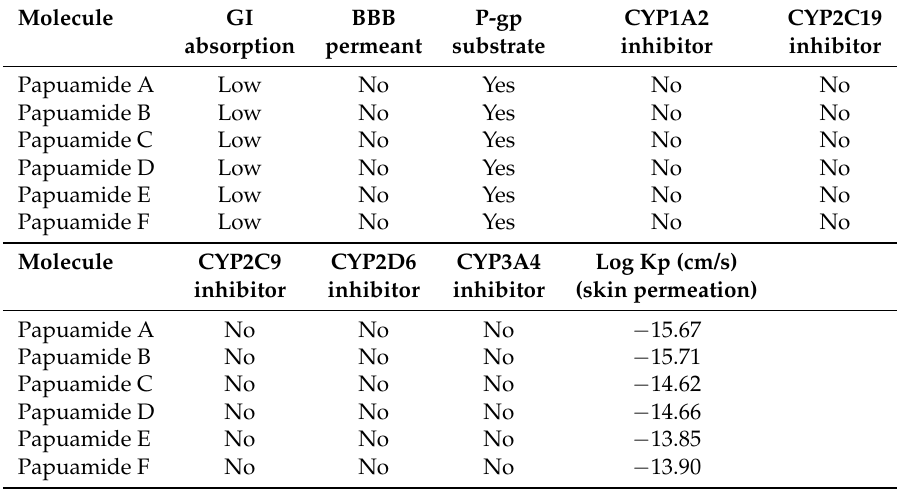
Table 6. Pharmacokinetics of Papuamides A–F marine